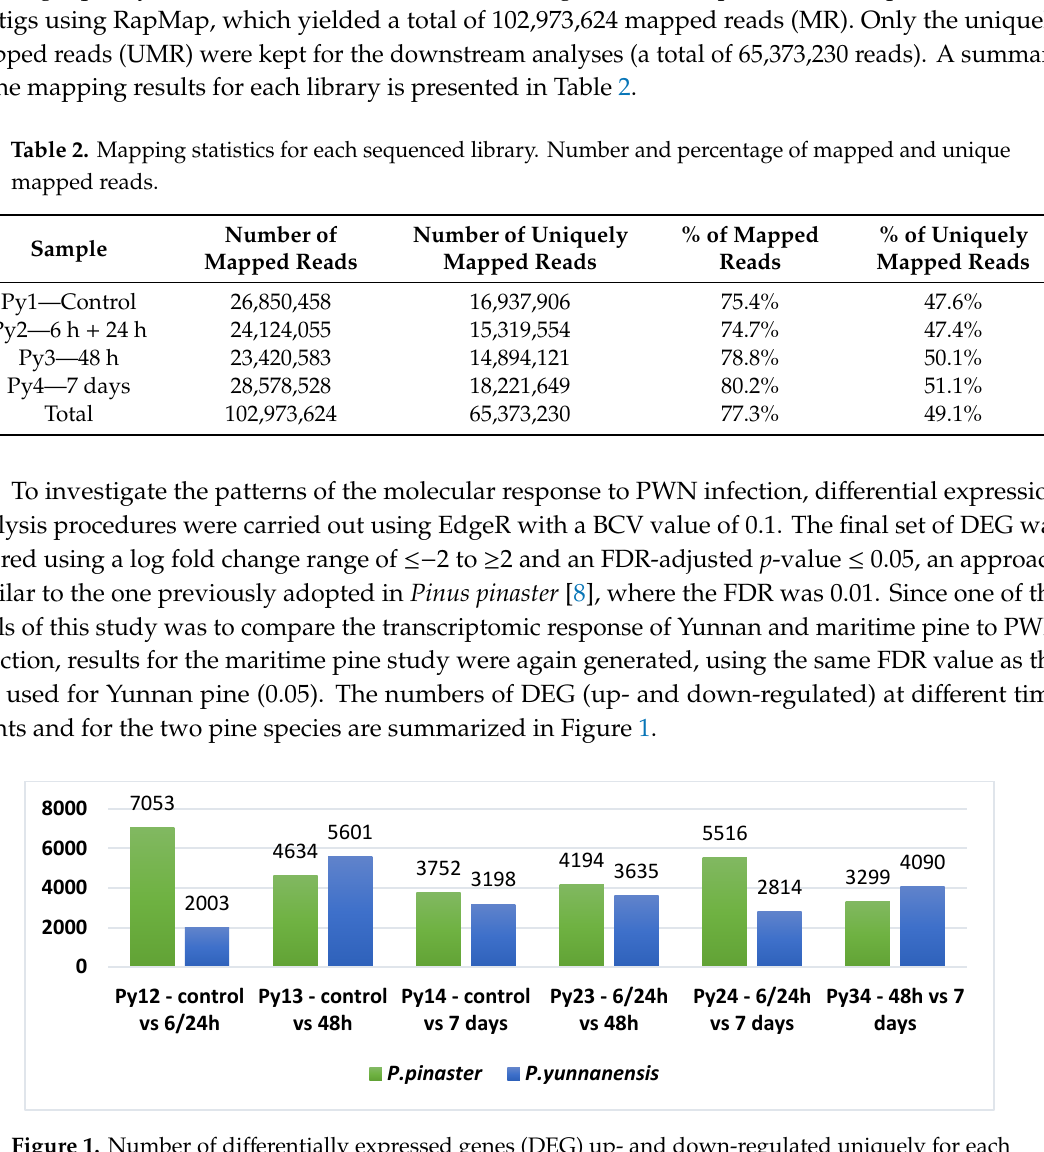
Figure 1. Number of differentially expressed genes (DEG) up- and down-regulated uniquely for each comparison. Pinus pinaster DEG are shown in green bars; Pinus yunnanensis DEG are shown in blue bars.